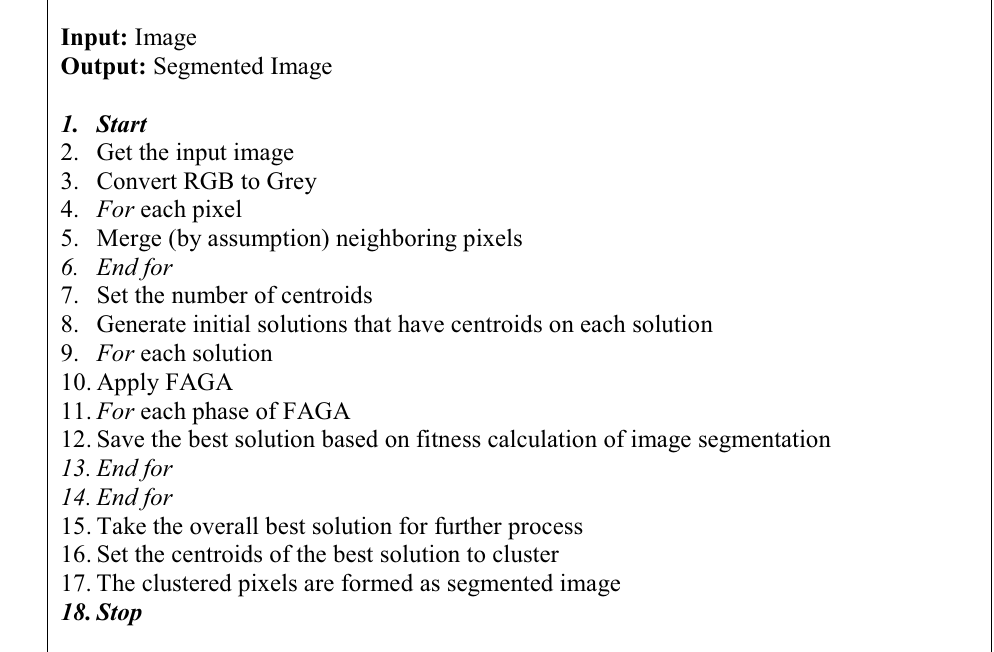
Fig.6. Algorithm for the application of FAGA on Image Segmentation